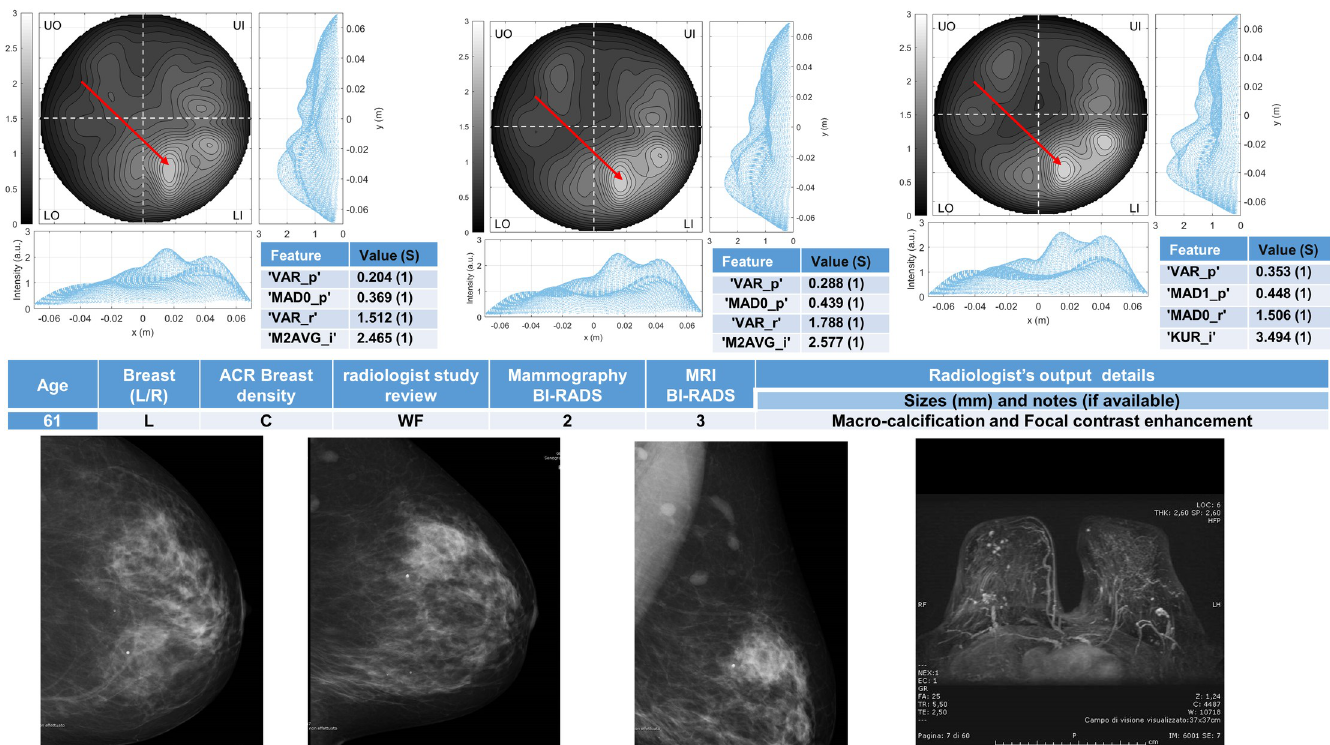
Fig 8. The radiologist study review “WF” for this heterogeneously dense (ACR C) breast has been obtained with the support of mammography and MRI images given in the bottom row, giving as output the presence of a macro-calcification and a focal contrast enhancement. The Mammography BI-RADS is 2 and the Magnetic Resonance Imaging (MRI) BI-RADS is 3. The final assessment is not available. Microwave images, normalized to unitary average of the intensity, are given in the top row for three different conductivity weighting (from left to right: 0.3 S/m, 0.4 S/m and 0.5 S/m, respectively). X and Y are given in meters; intensity is in arbitrary units. All microwave images show a non-homogeneous behavior, with a main peak indicated by the red arrows; a slightly lower peak in the same quadrant may be also noted. The binary score S (given in the inserted tables) is 1 for the all the features. The proposed rule-of-thumb classifies this breast as positive.